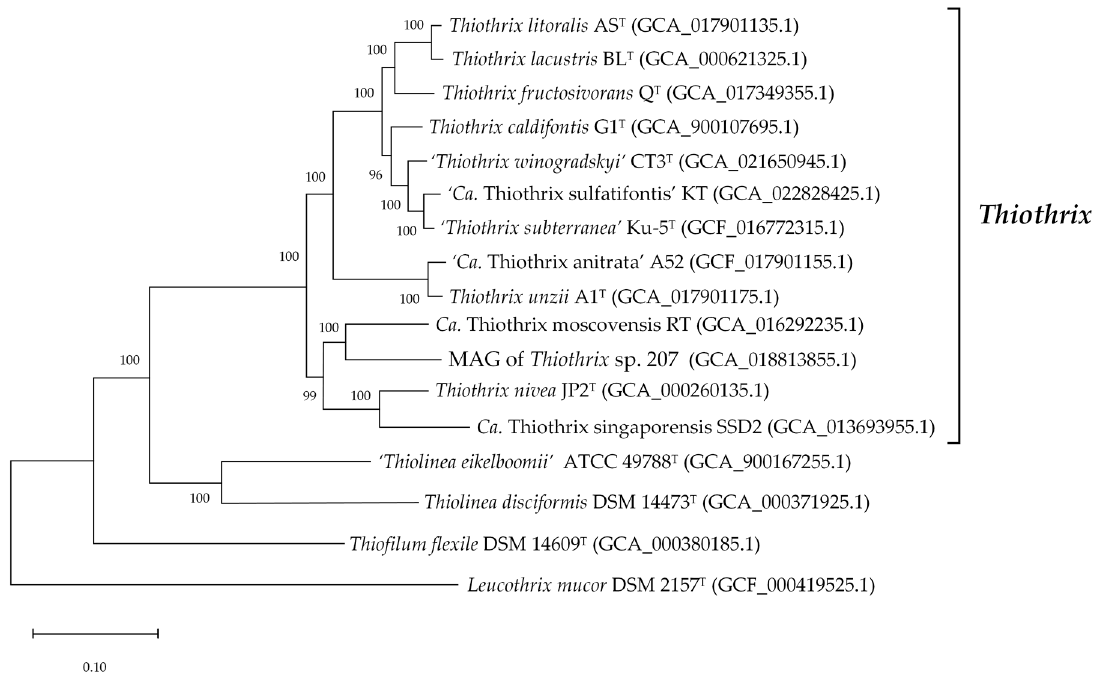
Figure 3. Genome-based phylogenetic tree of type strains of Thiothrix species. The GenBank assembly accession numbers are listed after the genome names. The internal branching support levels assessed by the Bayesian test in PhyML are specified in nodes. The genome of Leucothrix mucor DSM 2157 T was used for tree